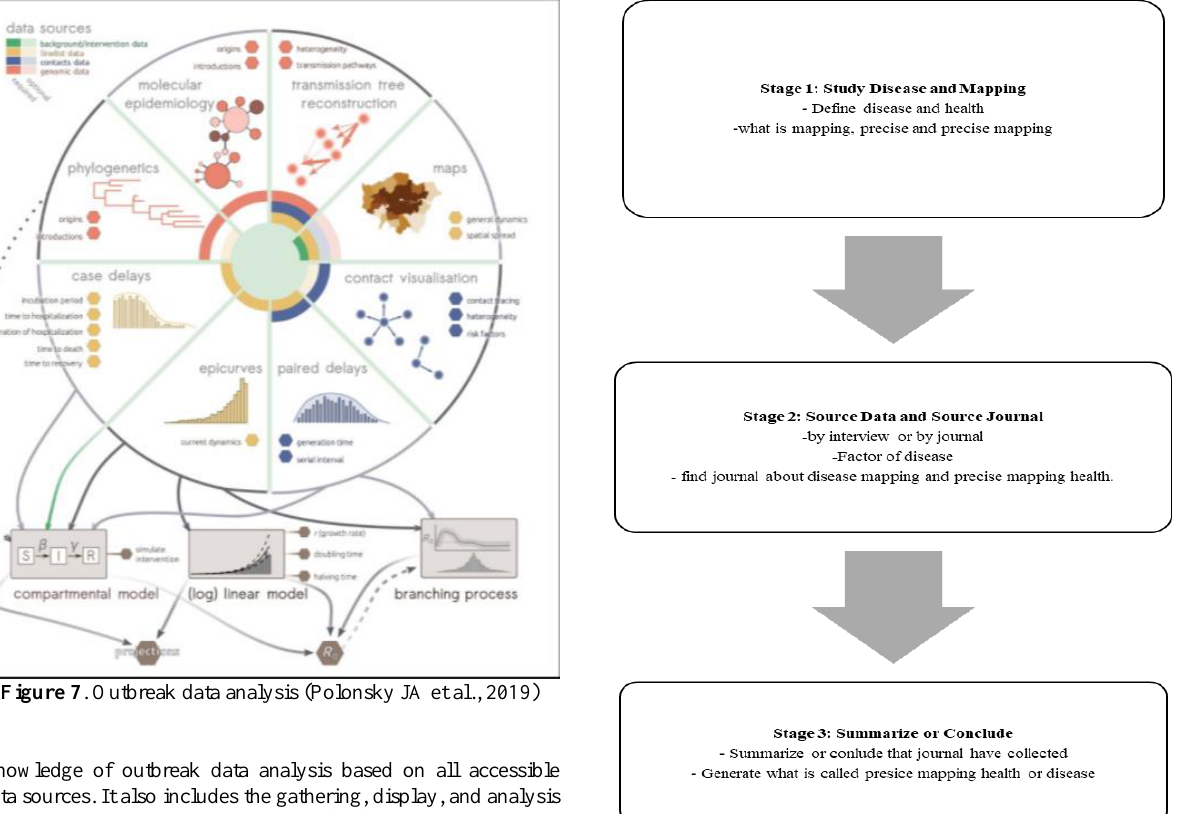
Figure 8 . Flow Chart of Research